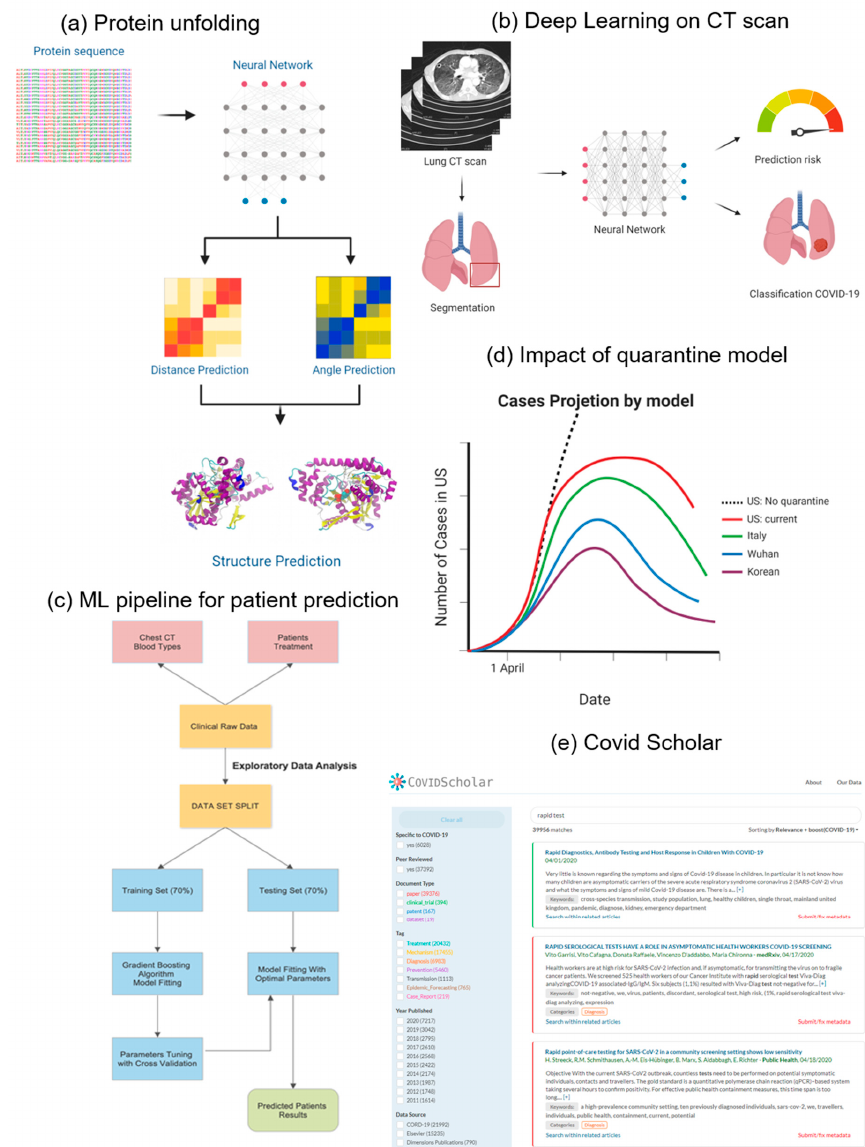
Figure 5. Machine learning analysis of COVID-19 dynamics. ( a ) Protein unfolding prediction. The first step is a multiple sequence alignment that compares a protein’s sequence with a similar one, suggesting a close location in the folded protein. The neural network learns to accurately predict the distance by training on precisely measured distances in proteins. In parallel, another neural network is trained to predict the angles of the joints in the folded protein chain. Finally, gradient descent is used to find a physically possible folding of a protein; ( b ) A deep-learning framework on a CT scan. First, the lung region is extracted using a segmentation method. Then, the corresponding image of the lung region is passed onto the deep-learning model that predicts the risk value based on the CT scan; ( c ) Machine Learning pipeline for patient risk forecasting; ( d ) Pandemic forecasting using machine learning under various quarantine rules. The model predicted the infected case count of the US with quarantine control and the exponential increase of cases if there were no quarantine measures. It also shows predicted case counts under various quarantine measures, as implemented in Wuhan, Italy, and South Korea. All of them led to a plateau of cases sooner than the US model; ( e ) COVID Scholar website for scientific article search. Searching for the term “rapid test” gives all journal articles related to the term. This can be further filtered depending on the year, the type of document, whether they were peer-reviewed, and whether they are specific to